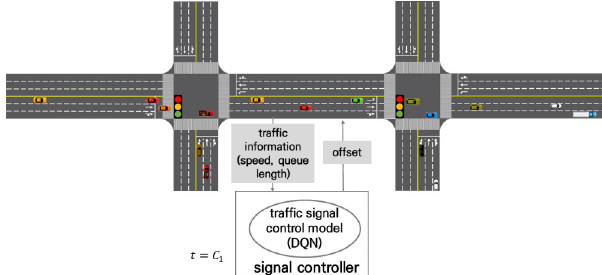
Fig 6. Traffic control method of coordinated